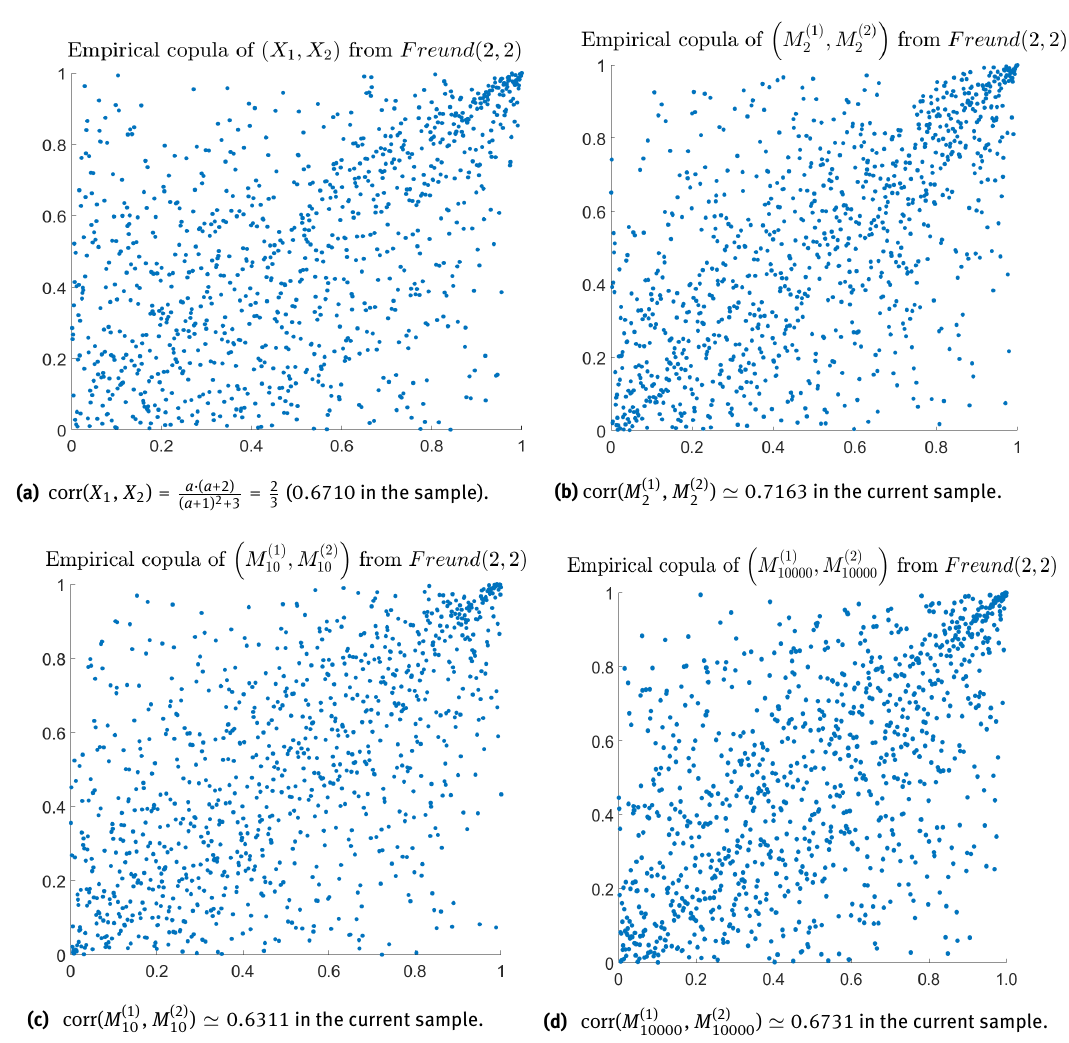
Figure 2: Scatterplots of componentwise maxima for a = 2